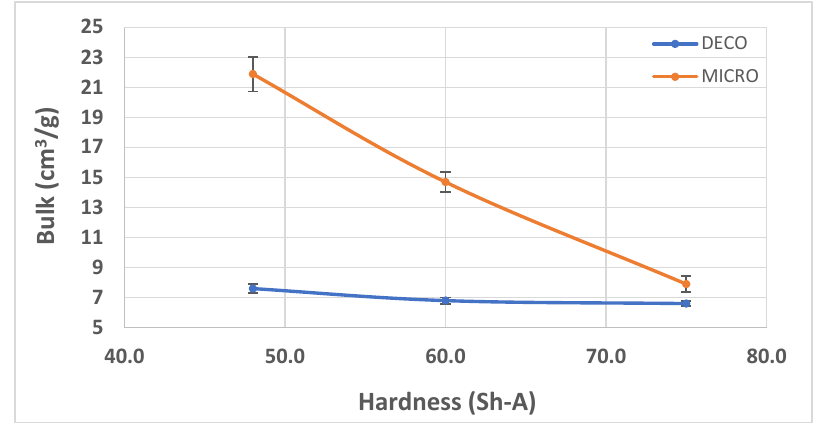
Figure 7. Bulk evolution with the increase in rubber hardness.